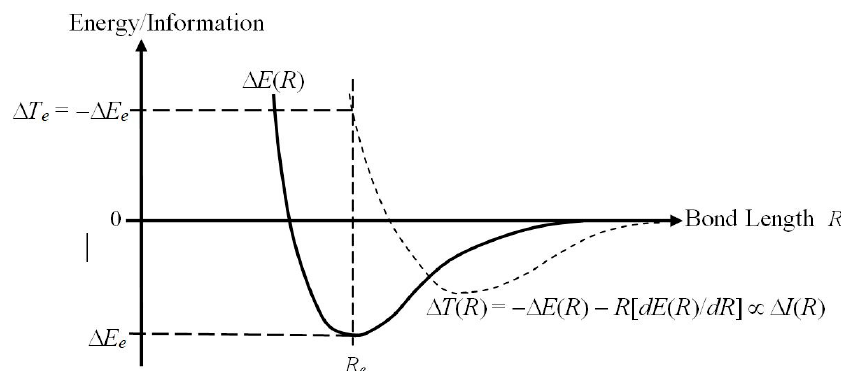
Figure 2. Variations of the electronic energy Δ E ( R ) (solid line) with the internuclear distance R in a diatomic molecule and of its kinetic energy component Δ T ( R ) (broken line) determined by the virial theorem partition.4. Reactivity Implications of Molecular Virial Theorem.